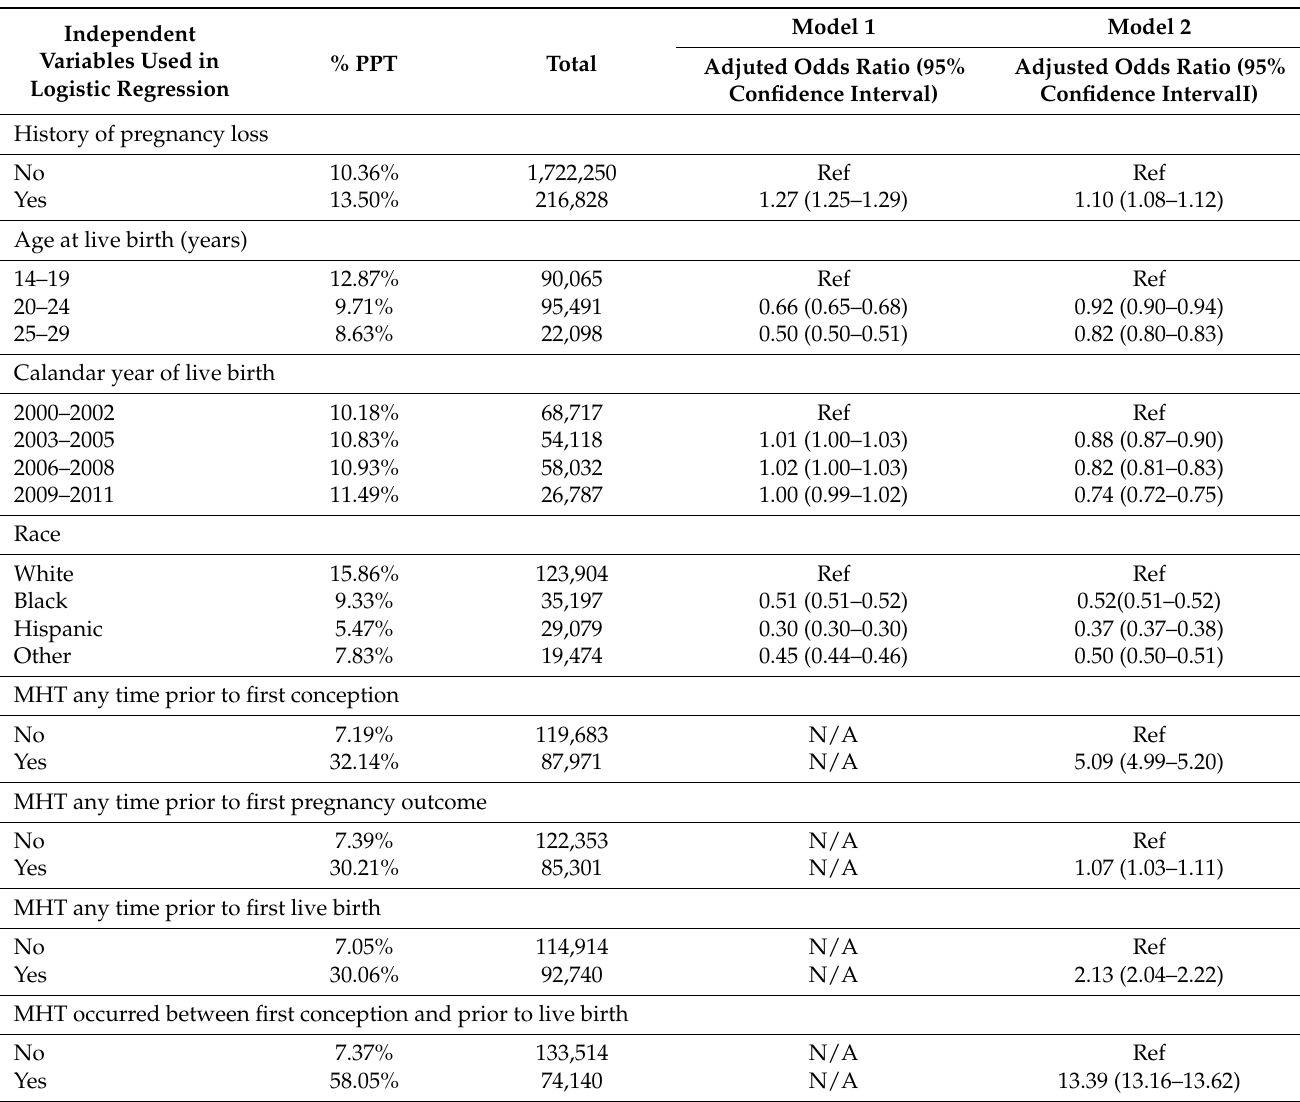
Table 3. PPT risk regression models for all women ( n = 1,939,078) controlling for first pregnancy outcome, age, race, and years of live birth, as well as history of mental health treatments